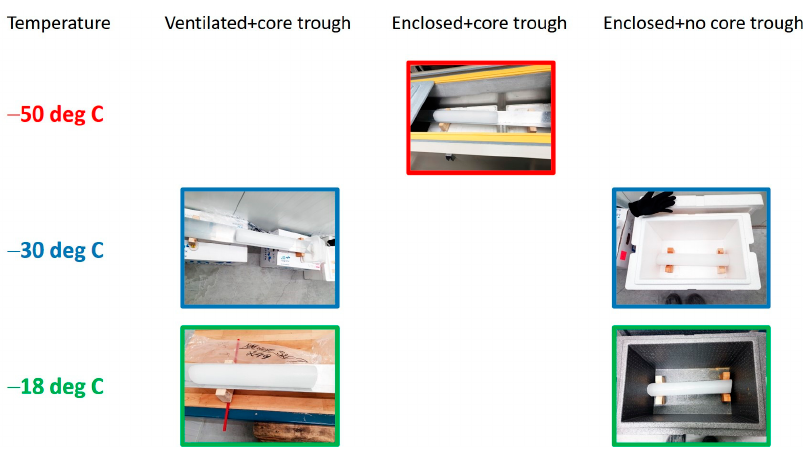
Figure 3. Configurations for the experimental tests on real 10 cm ice cores, 55 cm long.